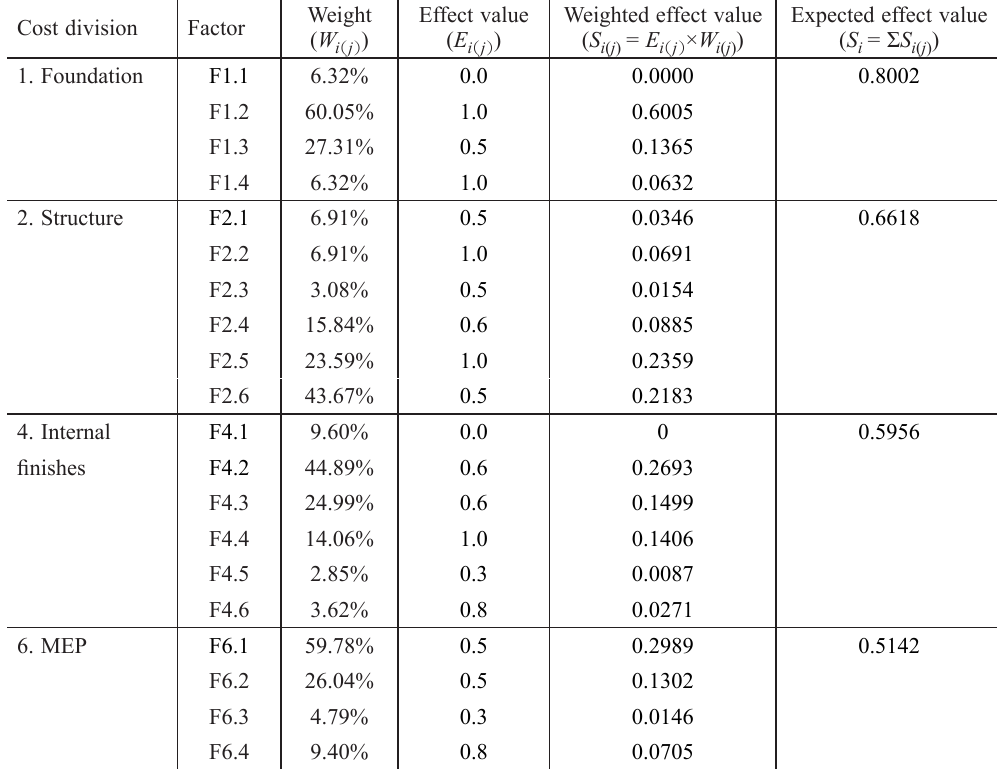
Table 5. W i ( j ) , E i ( j ) , S i ( j ) and S i for the four major cost divisions in case project